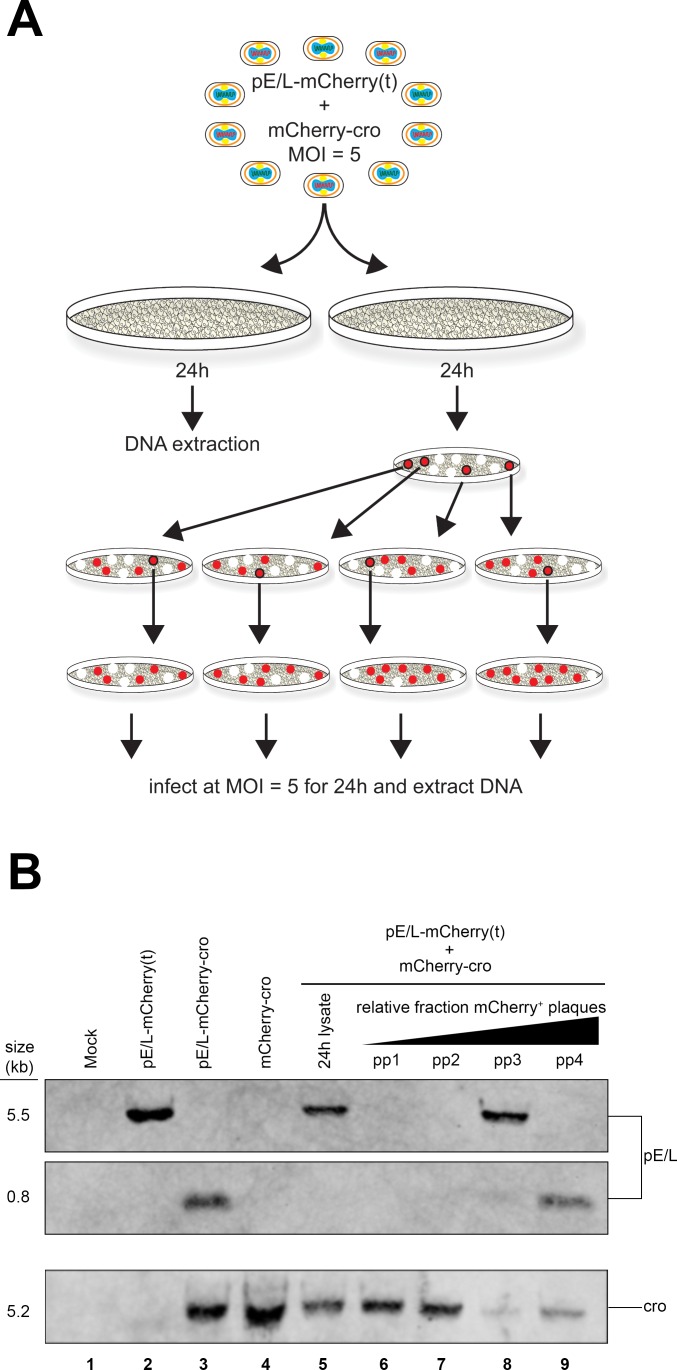
Southern blot analysis of recombinants.BSC-40 cells were infected (or co-infected) with the different indicated viruses, and Southern blotted to detect recombinants. (A) The scheme used to collect samples for Southern blotting. Some DNA was extracted directly from virus-infected cells 24 h after infection. Alternatively, the viruses were plated, red fluorescent plaques subjected to two rounds of plaque purification, and the virus expanded to produce sufficient DNA for Southern blots. (B) Southern blot analysis of virus DNAs. DNA was extracted from virus-infected BSC-40 cells, as in panel (A), digested with XhoI endonuclease, and blotted using biotin-labeled pE/L and cro probes (Fig 7A). A novel 0.8 kbp DNA fragment is diagnostic for recombinants (and is also found in the pE/L-mCherry-cro control virus), but this 0.8 kbp fragment is only detected after the recombinant viruses are subjected to several additional rounds of plaque purification.